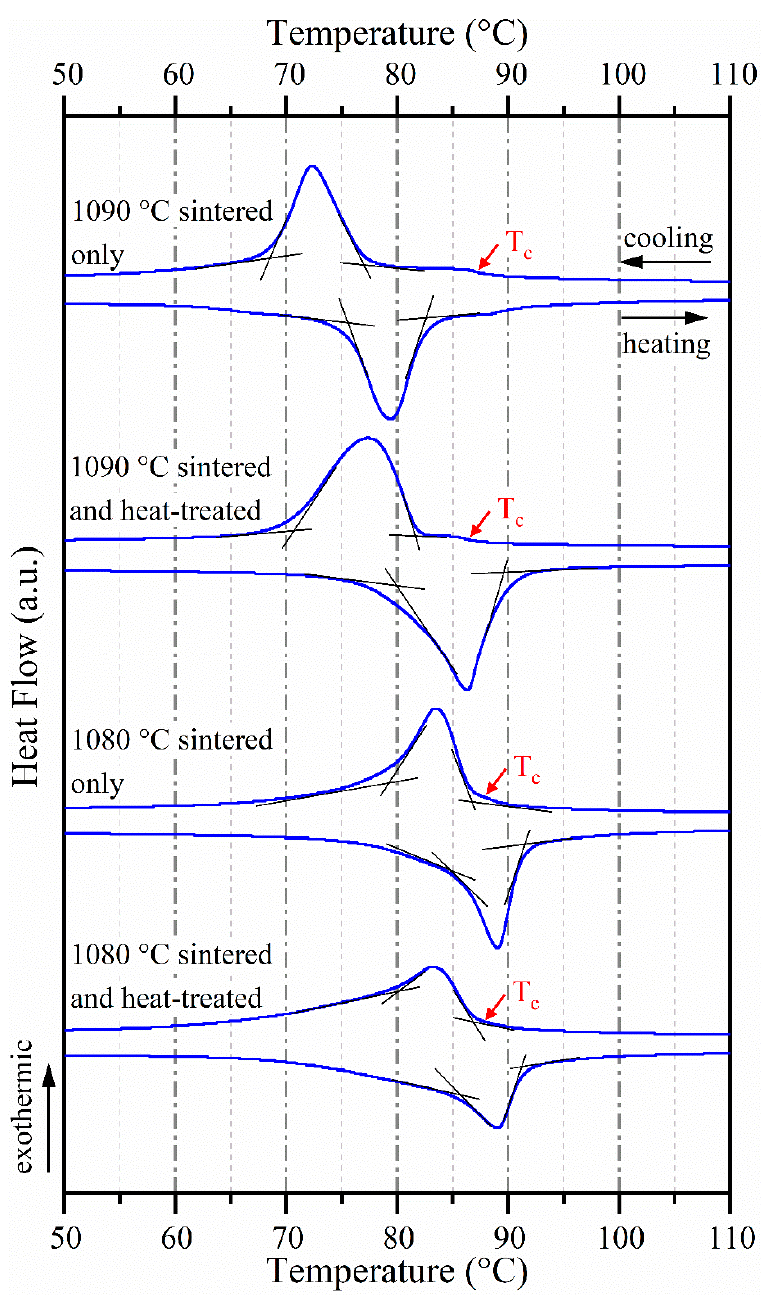
Figure 6. DSC curves presenting the transformation temperatures of the four investigated samples. Tangent lines at transformation onsets and ticks at peak maxima are presented to aid the eye. Curie temperature was determined at heat flow stepwise increase at ~90 °C. See Table 1 for observed transformation temperatures.